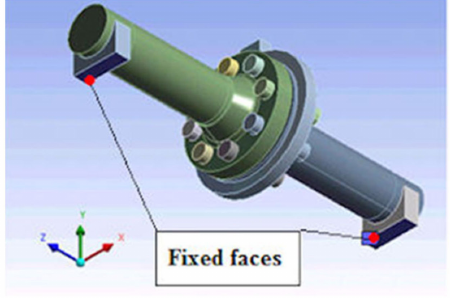
Figure 11. Model fixing